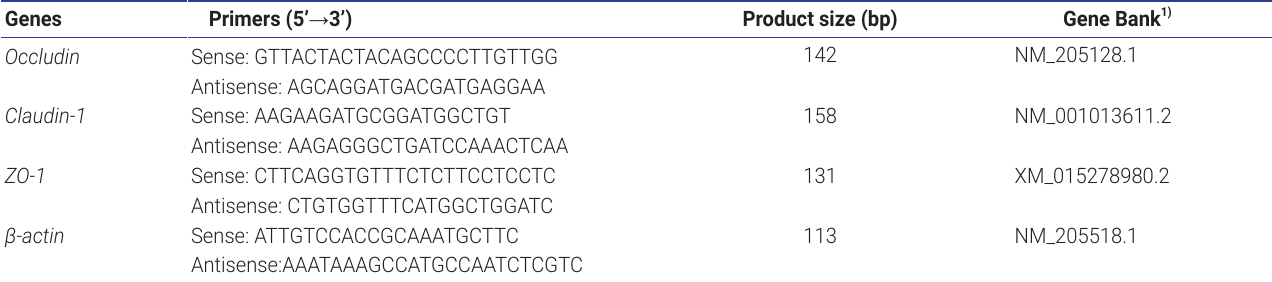
Table 2. Primers sequences used in RT-PCR